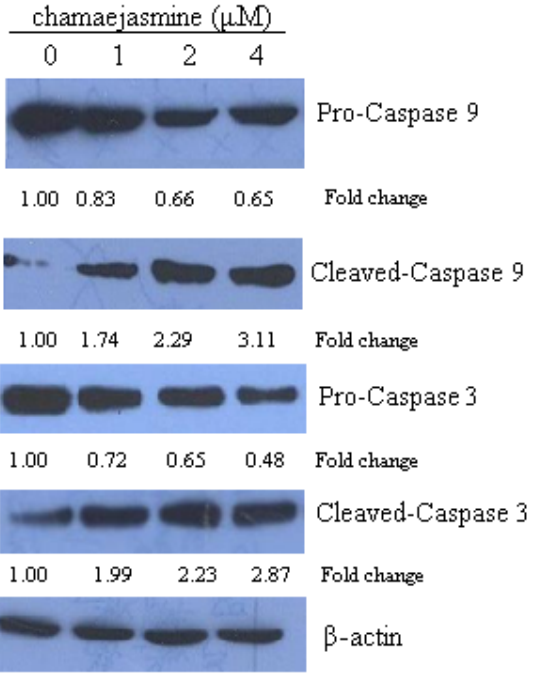
Figure 4. HEp-2 cells were exposed to 0, 1, 2 and 4 μ M chamaejasmine for 48 h, cell lysates were prepared and immunoblotted for procaspase-9, cleaved caspase-9, procaspase-3 and cleaved caspase-9. Change was calculated as described in Figure